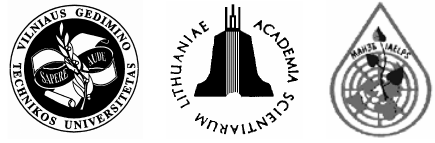
table territory from the territory of the